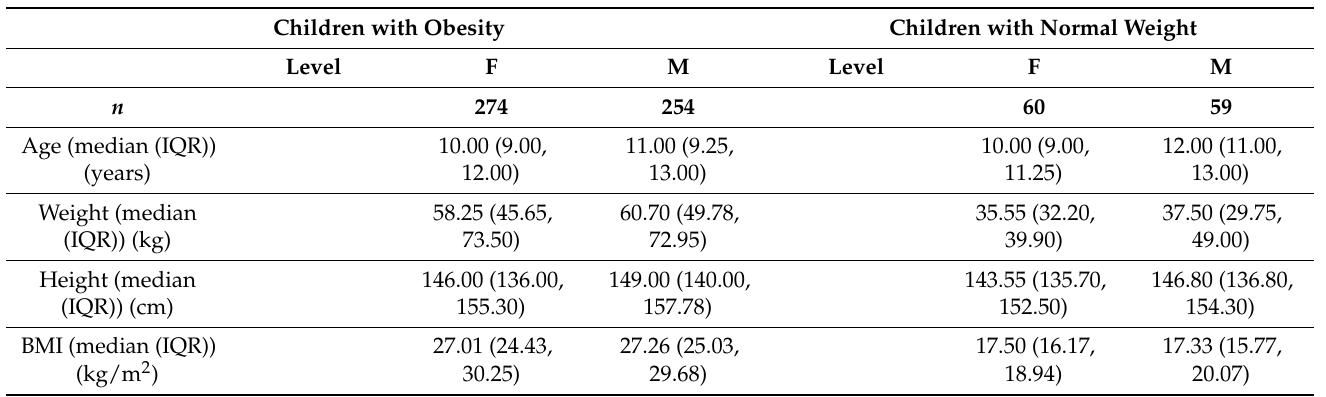
Table 1. Descriptive statistics of children with obesity (OB) and the control group